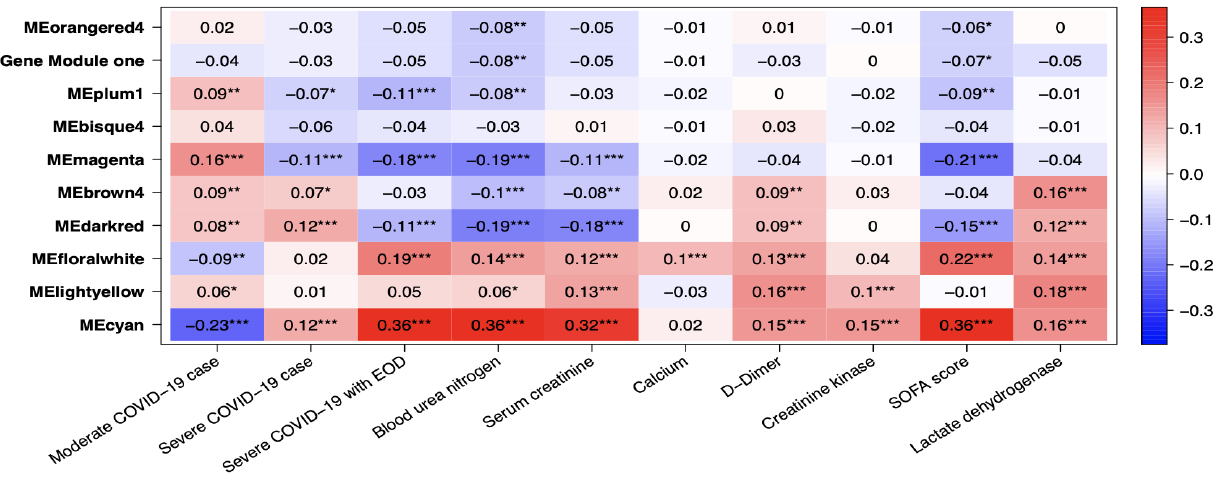
Figure 10. Heatmaps of module traits for severity and clinical biomarkers. The boxes indicate the correlation based on module eigengenes in the rows and traits in the column. The color legend — blue (negative correlation) and red (positive correlation). p -values represented by asterisks indicated significance. Asterix signs indicate the order of significance where *** — very significant, ** — significant, and * — significant.